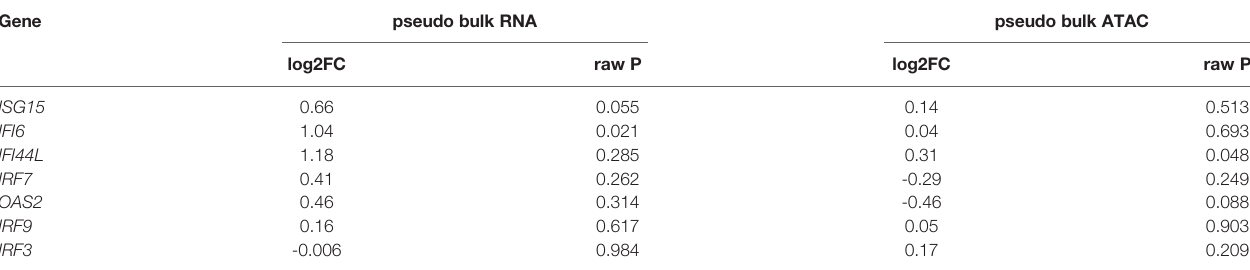
TABLE 2 | Expressions of interferon-stimulated genes analyzed by pseudo-bulk RNAseq and pseudo-bulk ATACseq. Gene pseudo bulk